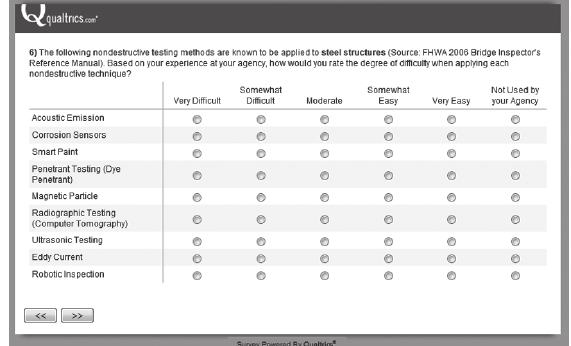
Fig. 1. Survey questionnaire